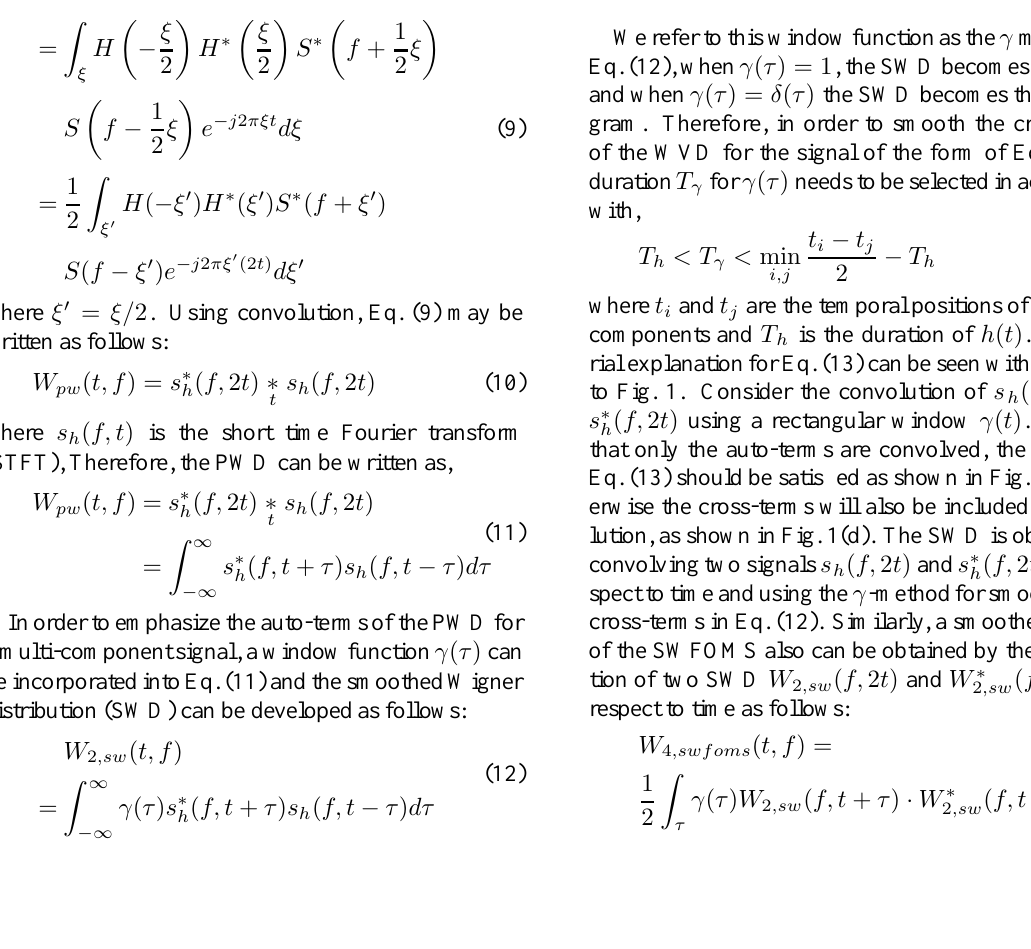
Fig. 4. The SWFOMS smoothed by the γ -method for the two component signals centered at 0.2 s and 1.08 s with 12.5